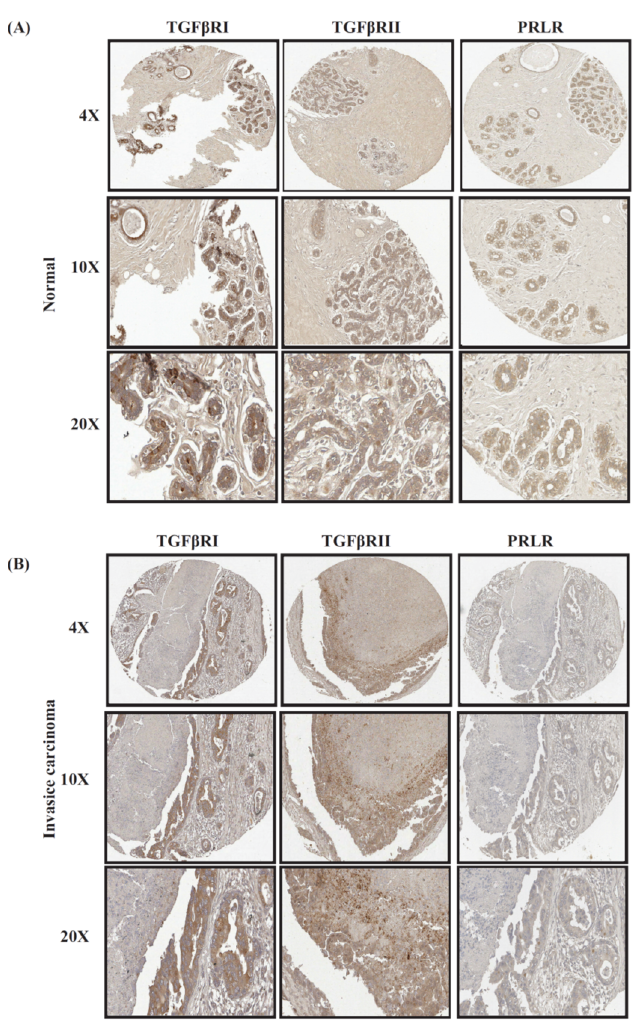
Figure 1. Representative images of co-expression of PRLR with both TGFβ receptors in ( A ) normal/benign samples; ( B ) invasive breast cancer samples.